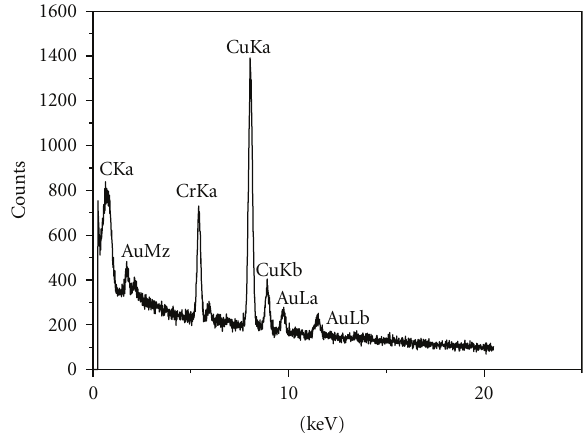
Figure 9: EDS spectra at the no. 9 point as indicated in Figure 6 (at the junction of the platinum and tungsten nanowires).